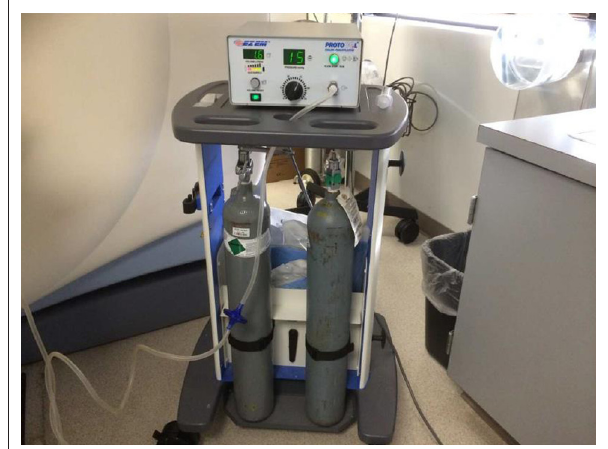
FIGURE 3: The CO 2 insufflator.